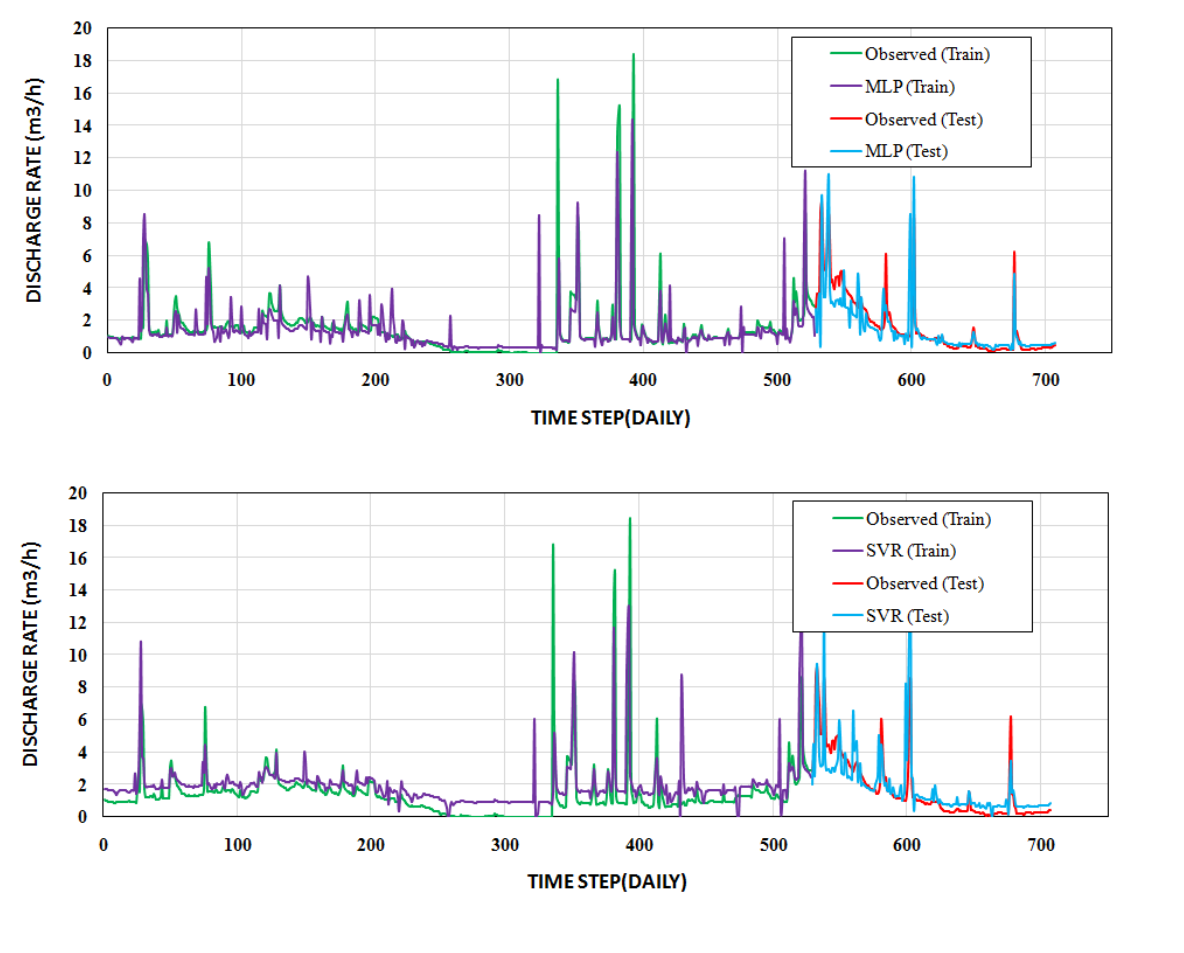
Figure 6: The simulated time series of the flow by models of MLP and SVR according to RT_TRMM